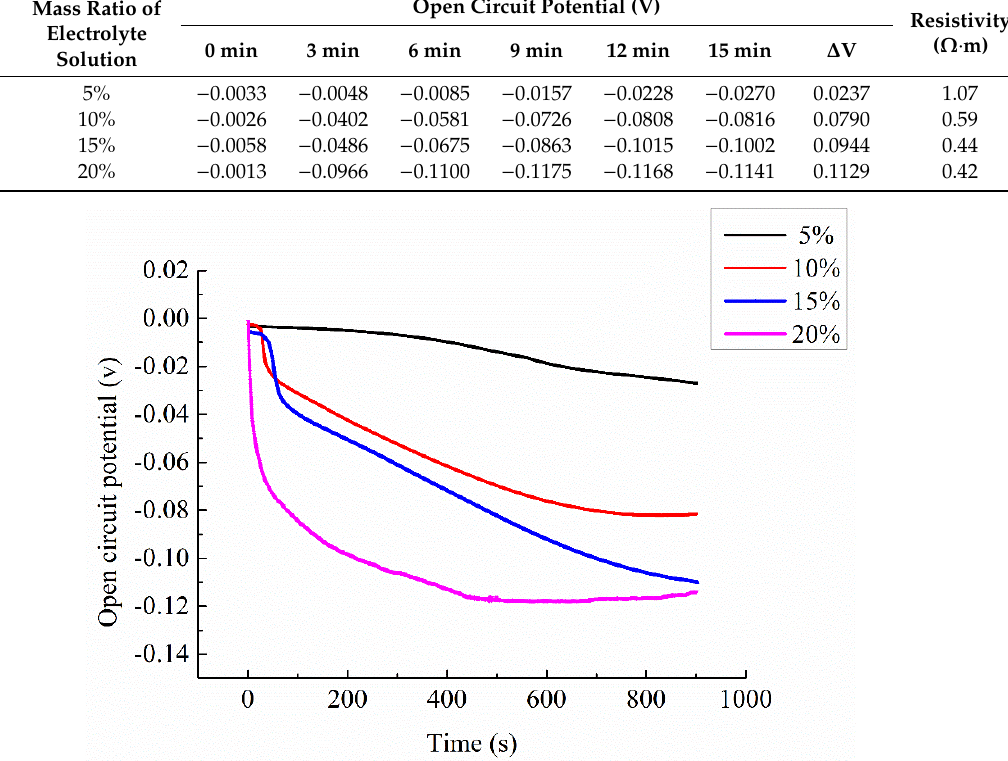
Figure 5. Change of open circuit potential of specimens with different mass ratio electrolyte solution.